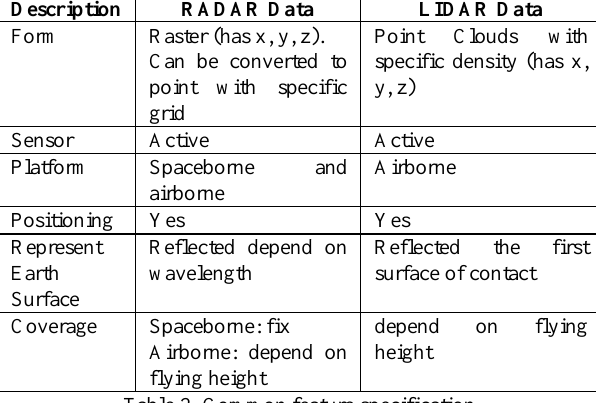
Table 2. Common feature specification